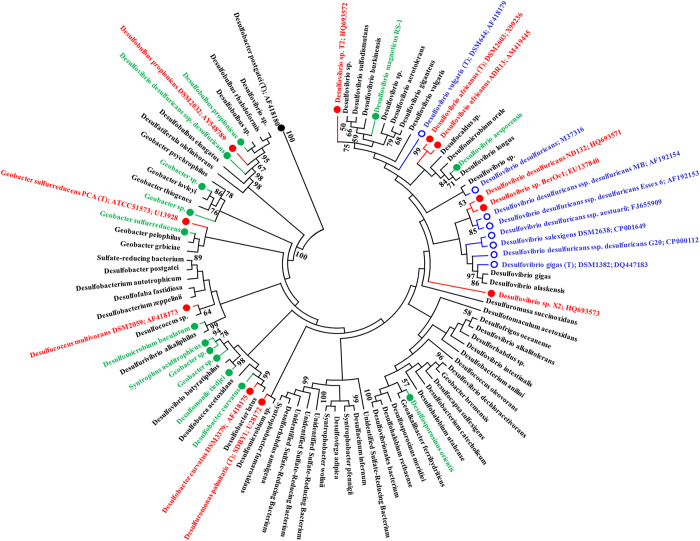
16S rRNA gene phylogeny for the predicted methylators identified in DWW samples.Type strains are indicated by – ‘T’. Desulfobacter postgatei was used as a reference and outgroup taxon. Strains reported to produce MeHg are shown with a filled red circle , those unable to do so are shown with an open blue circle , and strains with a filled green circle  are predicted methylators (from this study). The evolutionary history was inferred using the neighbor-joining method and the evolutionary analyses were conducted in MEGA.